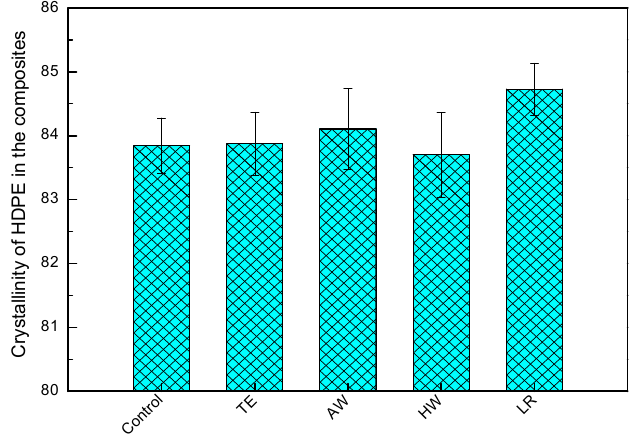
Figure 2. Crystallinity of HDPE in the samples after weathering.